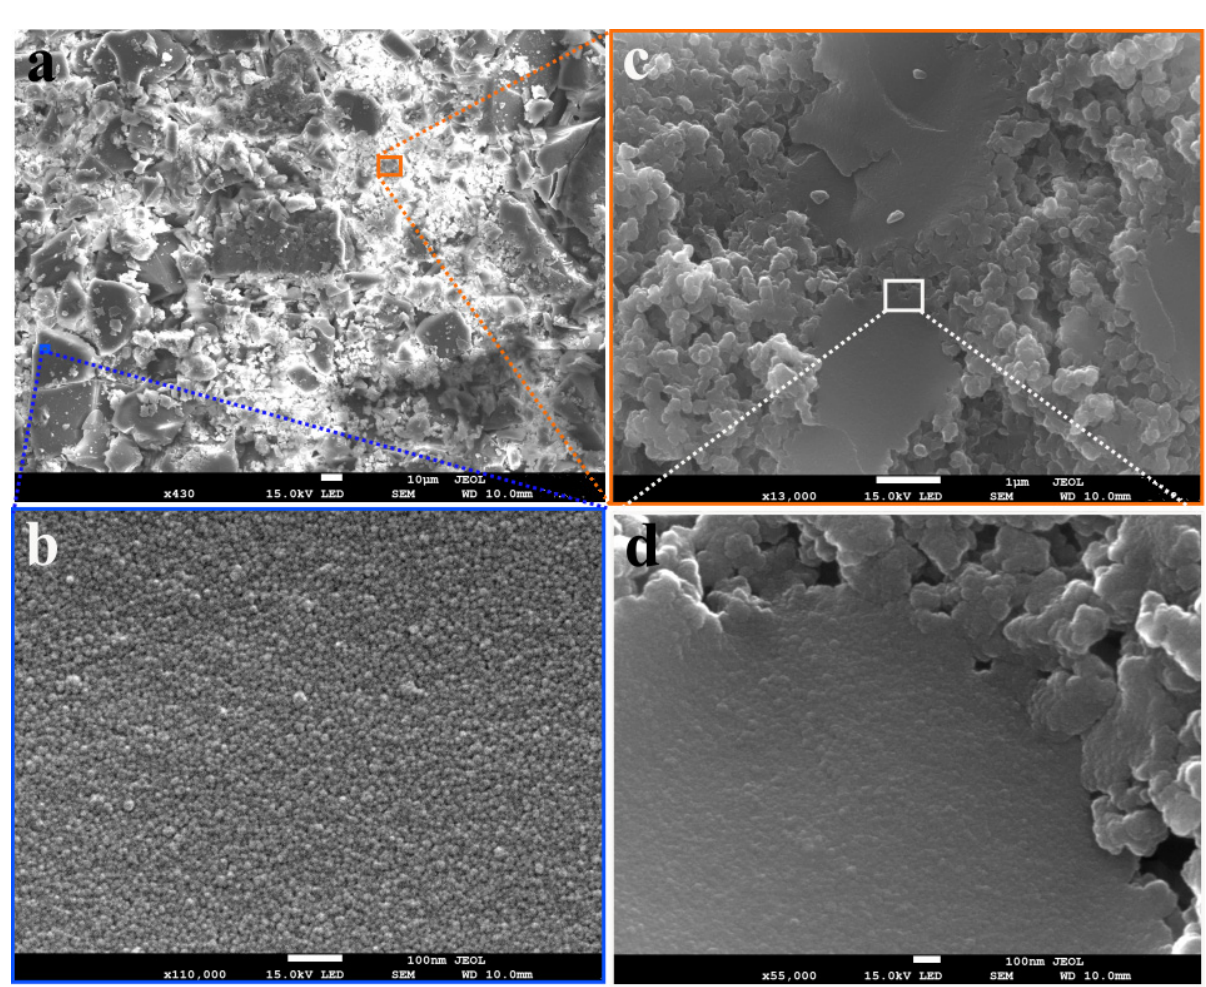
Figure 10. SEM image taken at low magnification for the char produced at 573 K and 10 min residence time; ( b ) high magnification (×110,000) image of the area indicated as blue color small square in part ( a ); ( c ) high magnification (×13,000) image of the area indicated as orange color small square in part ( a ); ( d ) high magnification (×55,000) image of the area indicated by a white color square in part ( c ).